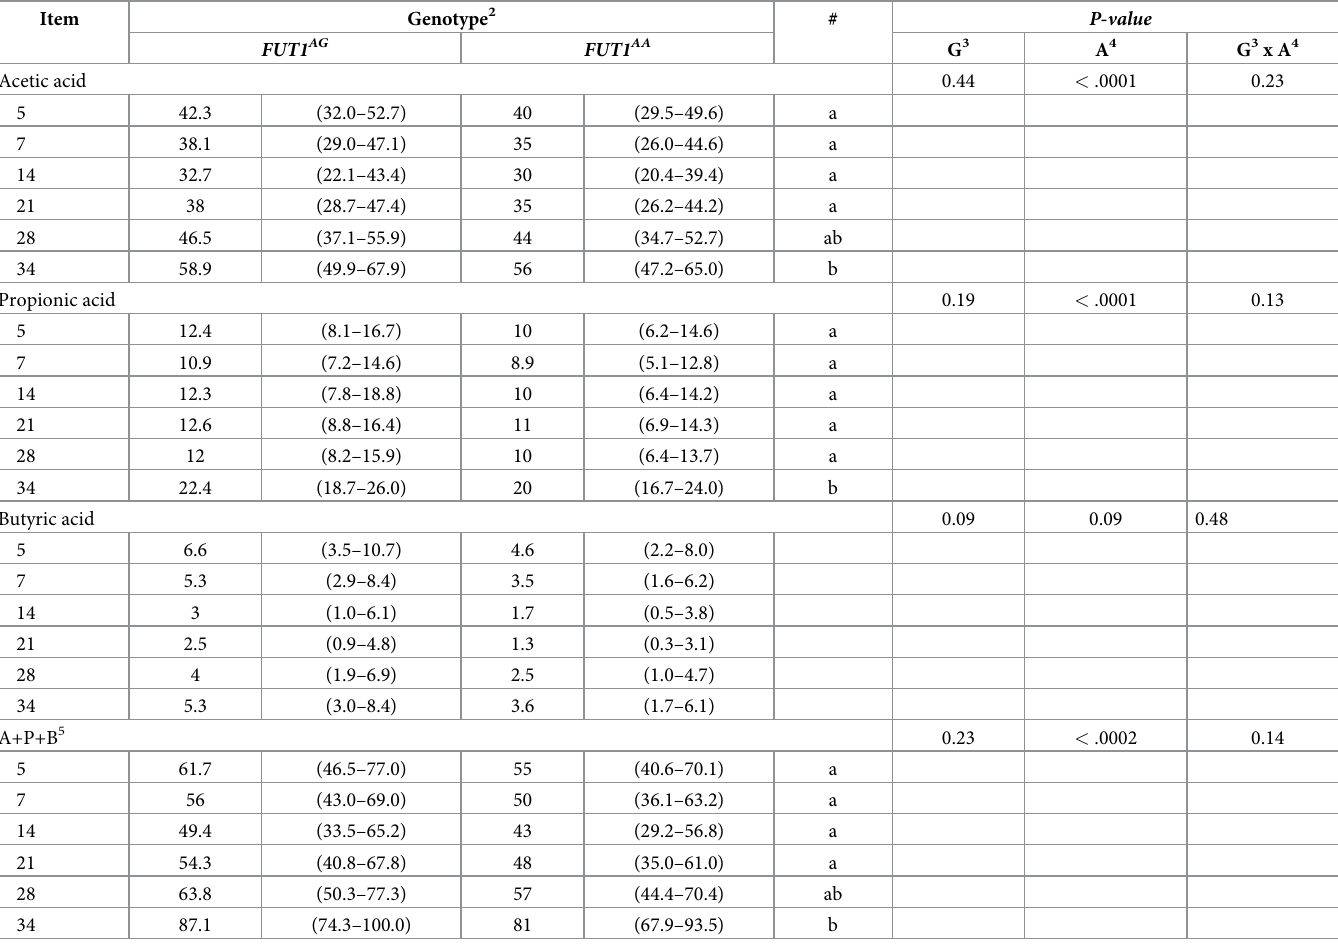
Table 3. Short-chain fatty acid concentration (mmol/kg sample) in faeces from FUT1 AG and FUT1 AA piglets at 5, 7, 14, 21, 28, and 34 days of age 1